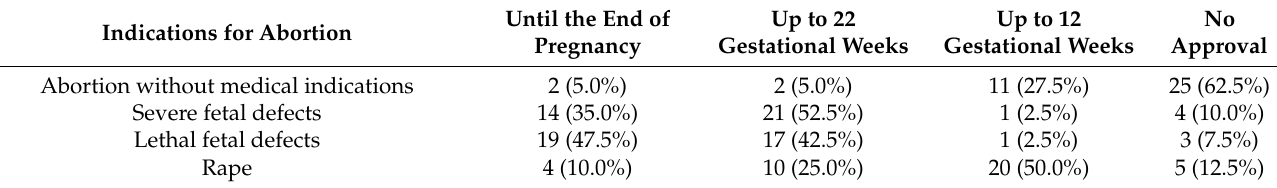
Table 2. Approval of pregnancy terminations in individual clinical